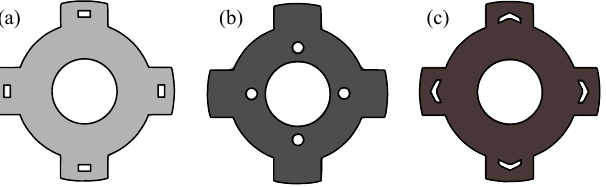
Figure 4. Rotor notch designs for acoustic noise reduction: ( a ) square notches [42], ( b ) circular notches [43], and ( c ) arrow notches